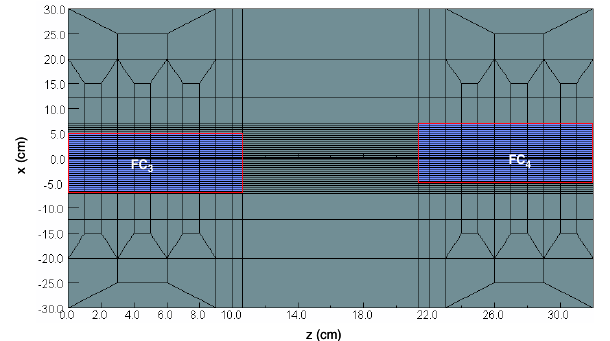
FIG. 12. (Color) Section in the z - x plane of the short model of the wiggler for the preliminary optimization. The steps in the region of the poles are of 1 cm in z and 0.4 cm in x . The structure of trapezes from x (cid:3) (cid:8) 12 : 25 cm to x (cid:3) (cid:8) 30 cm is to have a high number of nodes in the region of the fit without unnecessa- rily increasing the subdivisions at the boundary of the